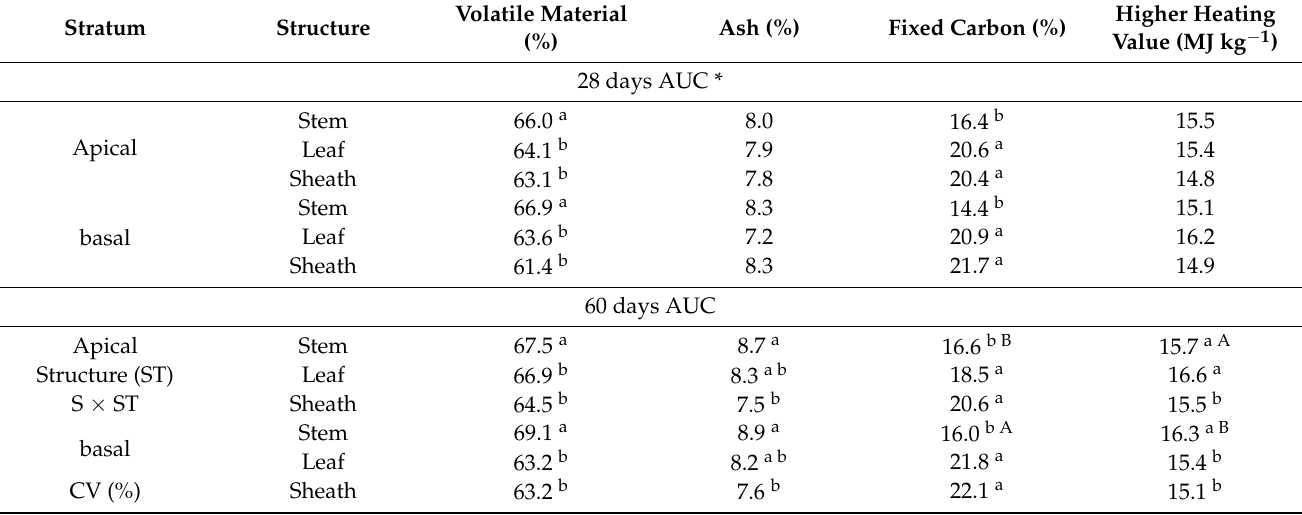
Table 2. Average values of proximal biomass analyses in different strata and organs of maralfalfa ( Cenchrus purpureus (Schumach.), Morrone) on different days after uniformity